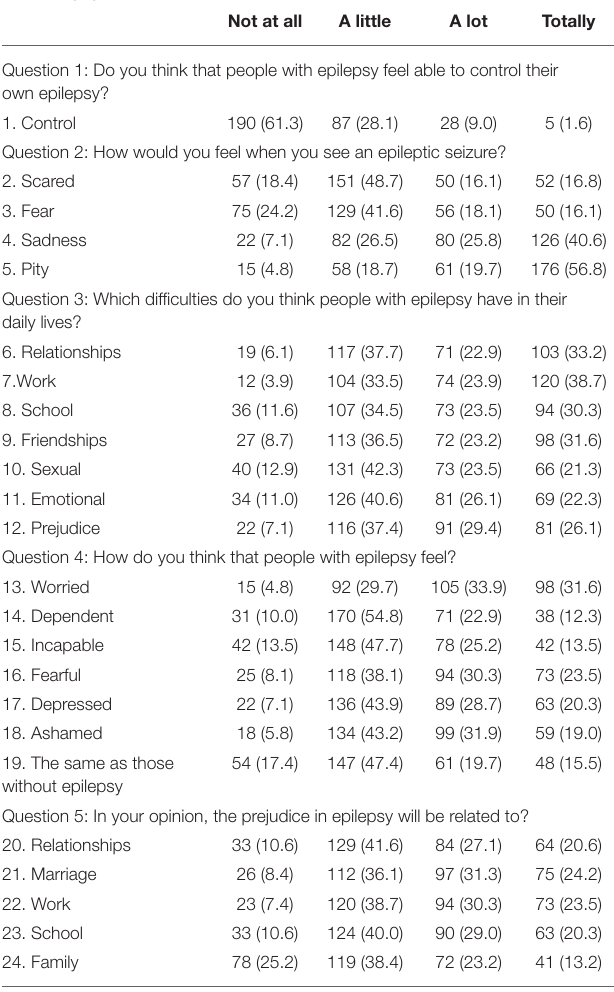
TABLE 2 | Felt stigma measures using the Stigma Scale of Epilepsy (SSE). Stigma scale of epilepsy, number